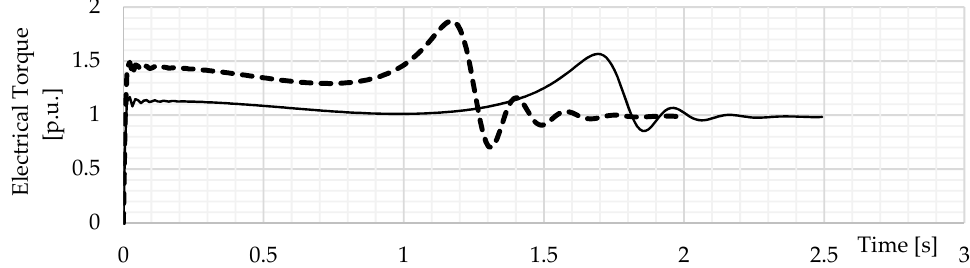
Figure 10. Electrical torque during the 110 kW asynchronous motor start with SVC implemented (dashed line) and without SVC implemented (solid line). Higher electrical torque causes faster ramp-up of the simulated motor—Figure 11.